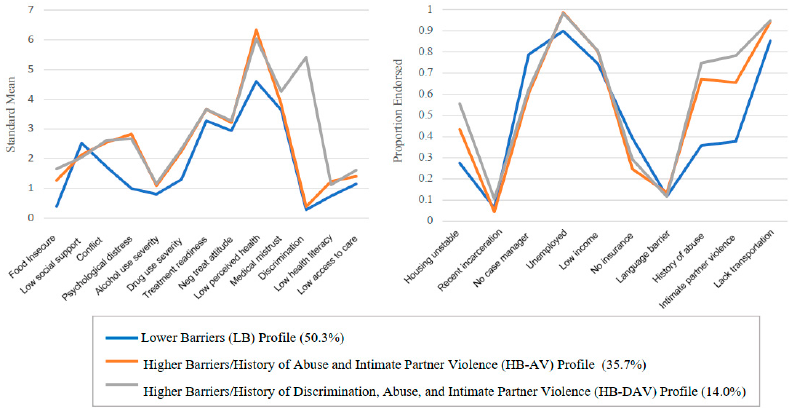
Figure 1. Visualization of Three-Class Latent Profile Analysis solution using 23 indicators of barriers to care.